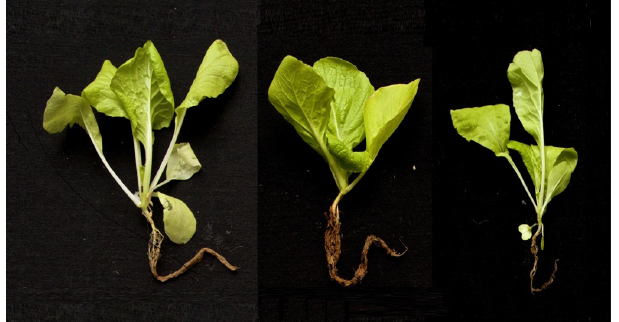
Figure 3. Growth of Pak choi for each treatment. On the right is the high-temperature (HVT) oscillation pattern, in the middle is the fixed temperature (CT) regime, and on the left is the inside temperature conditions of a net house.